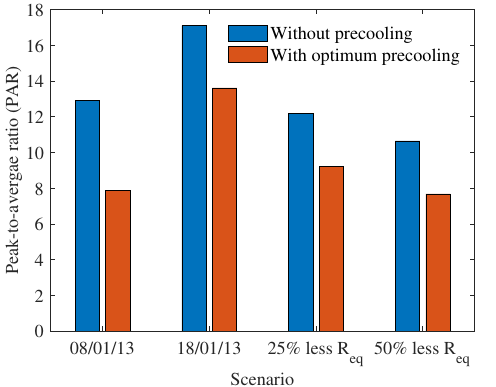
Figure 8. Peak-to-average ratio of house 165 for the different scenarios considered in the case study.